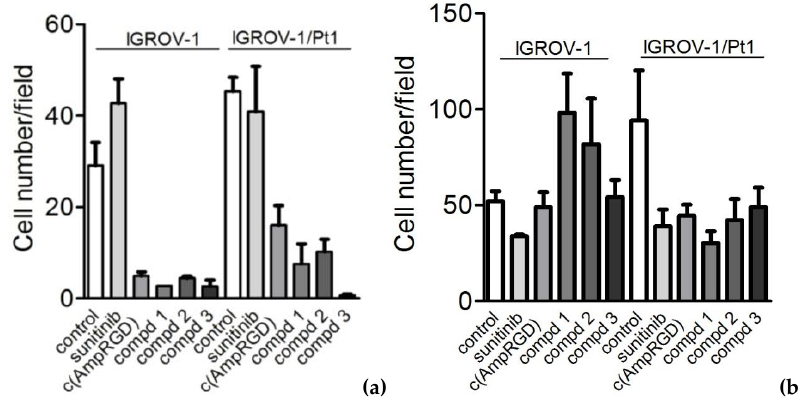
Figure 4. Modulation of migratory and invasive abilities of IGROV-1 and IGROV-1 / Pt1 cells by sunitinib and selective binders of α V β 3 integrin namely, c(AmpRGD) alone or linked to sunitinib (compounds 1 – 3 ). Cells were subjected to migration ( a ) and invasion assays ( b ) in serum-free medium using transwell plates after exposure to the compounds (10 µ M). Migrating and invading cells were counted under a light microscope. Columns represent cell numbers/field (± SE; n = 3).